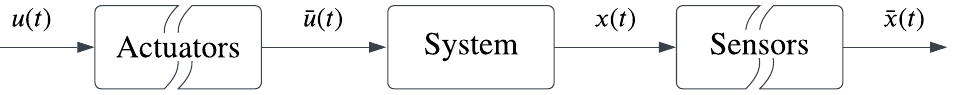
Figure 4. Components of a fault-tolerant control that are prone to failure. u ( t ) is the control signal, ¯ u ( t ) the actuator signal, x ( t ) the system signal, ¯ x ( t ) the sensor signal and t the current